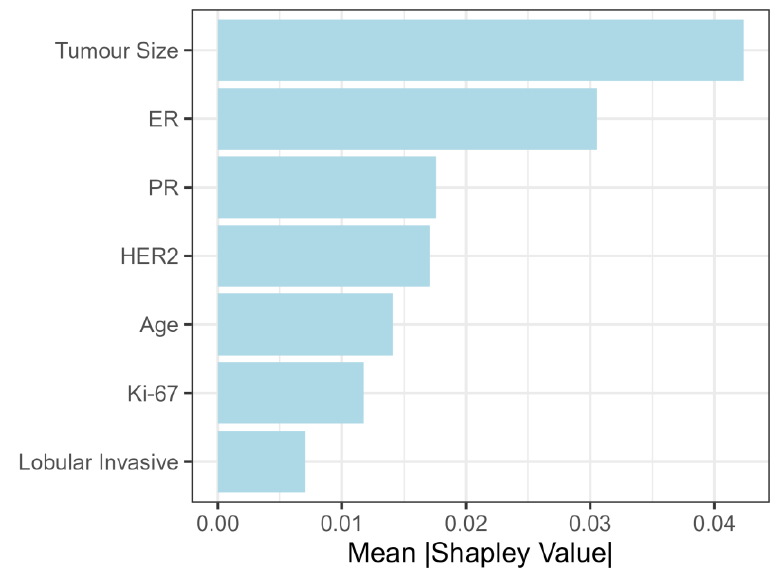
Figure 4. Shapley values (feature importance) for NST